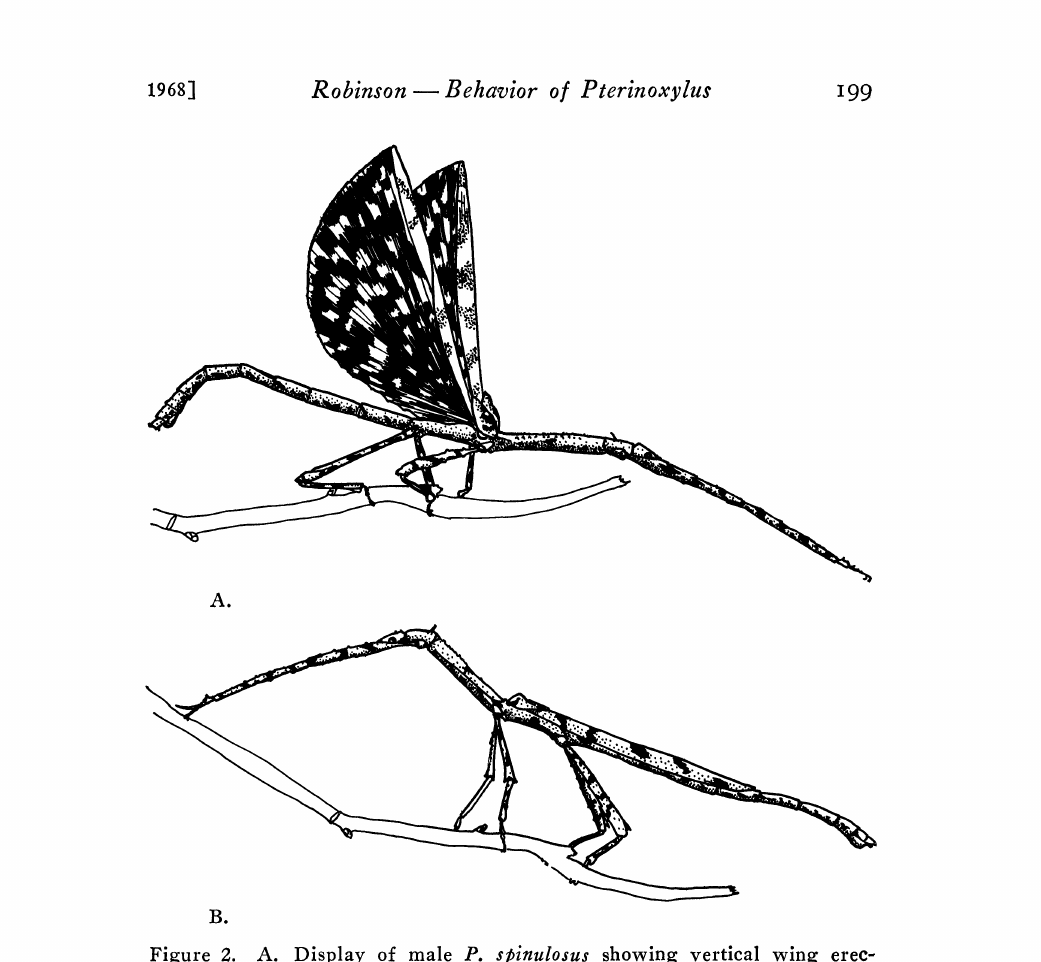
Figure 2. A. Display of male P. spinulosus showing vertical wing erec- tion and commencement of body flexure. B. Bizarre attitude assumed after display by male P. spinulosus. (Based on photographs by N. D. E. Smythe). expanded the wings are moved against the. tegmina as shown